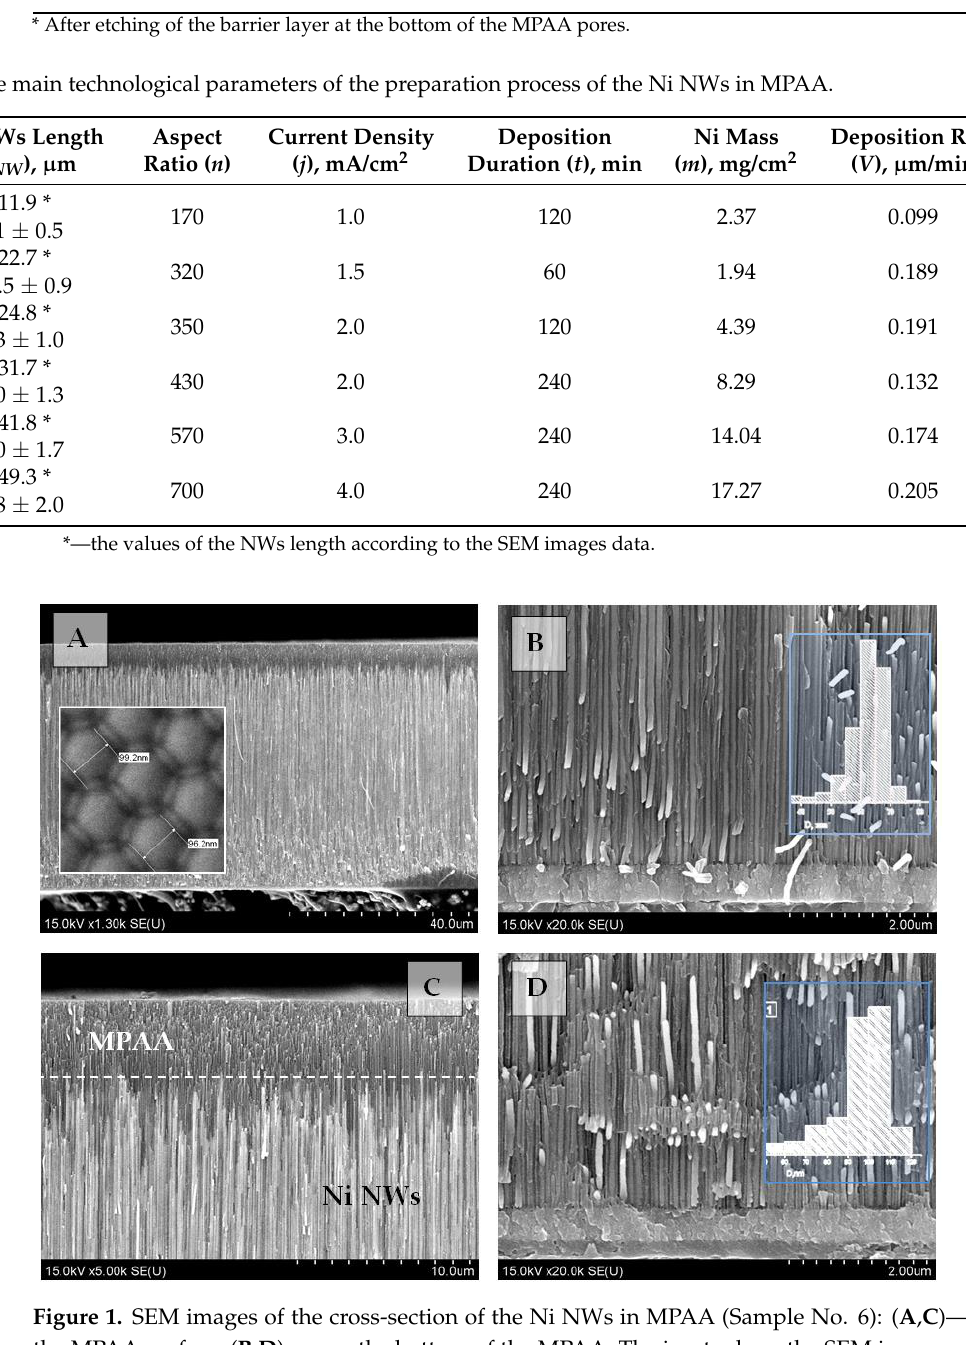
( B ) Figure 2. The dependences of the mass of the electrodeposited Ni ( A ) and the Ni NW length ( B ) on the current density at different deposition durations: 1—120 min; 2—240 min.